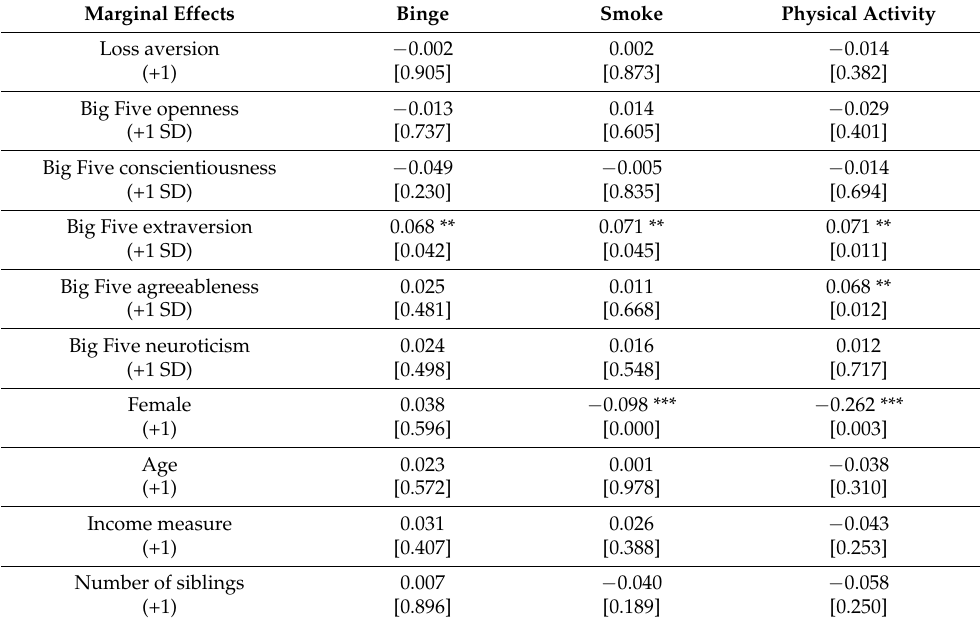
Table 4. Korean sample, probit regressions, marginal effects.